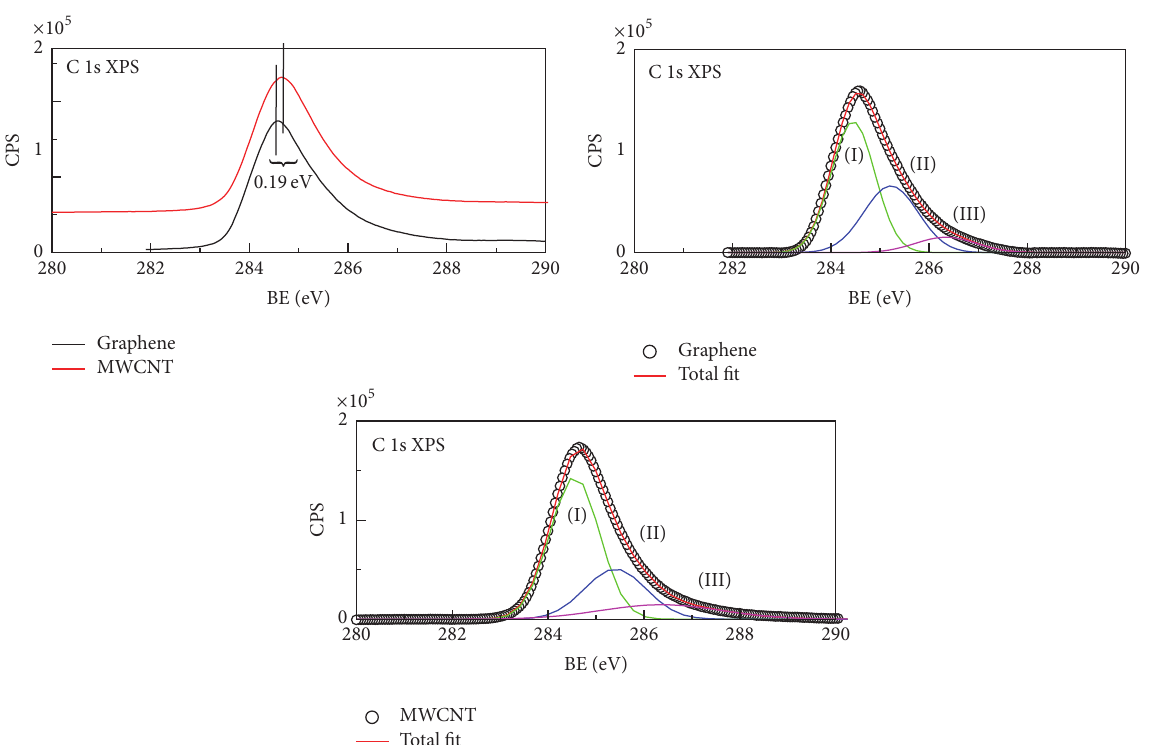
Figure 3: C 1s XPS spectra of graphene and MWCNTs. Deconvolution into three Gaussian components for each FLG and MWCNTs.